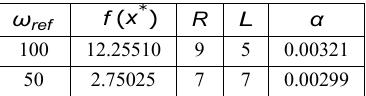
Table III O PTIMIZATION OF GAINS USING THE H EURISTIC M ETHOD .